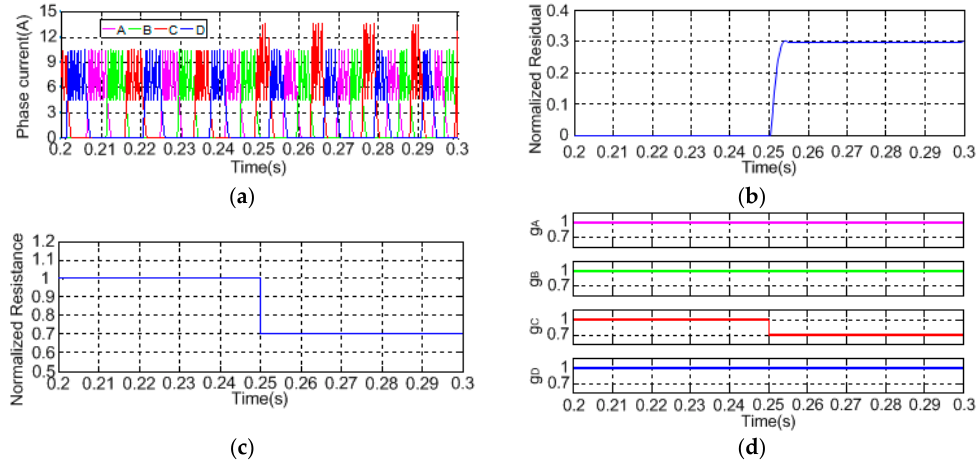
Figure 6. Simulation results in case of 30% turns fault of the SRM winding at low speed and no-load ( a ) four-phase currents; ( b ) normalized residual; ( c ) normalized resistance; and ( d ) diagnostic variables g n.